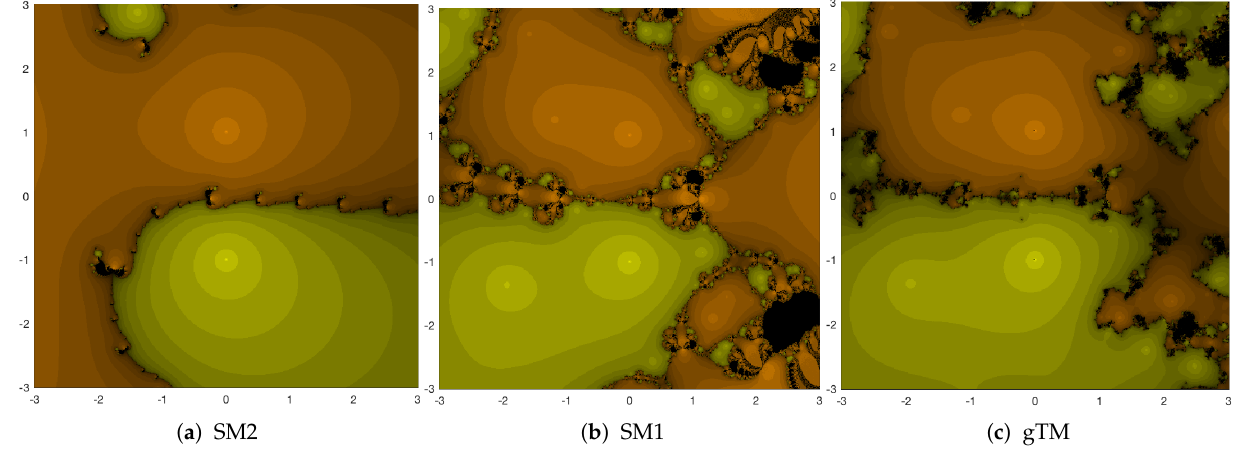
Figure 7. Dynamical planes of Schröder methods and gTM on f 5 ( x ) .